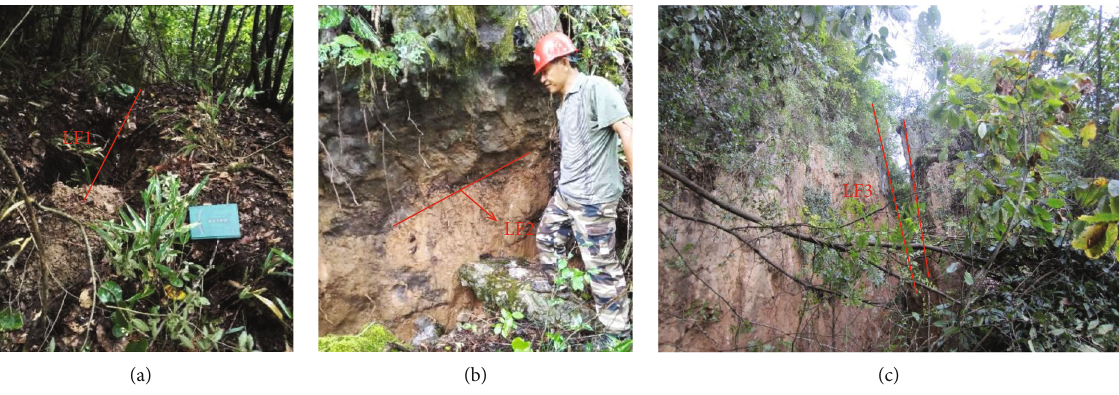
Figure 7: Fissure of Tanziyan landslide geological disaster.